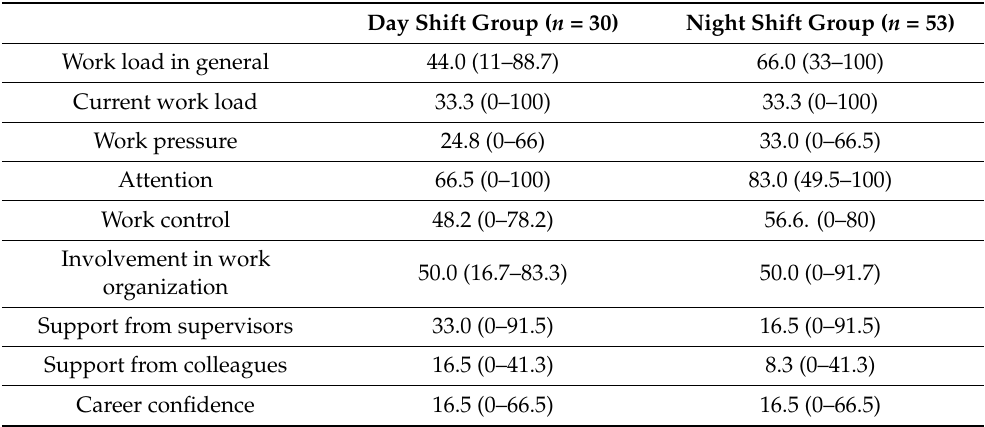
Table 2. Median (range) self-reported scores for occupational stress risk factors (from the French National Research and Safety Institute questionnaire) in the day shift and night shift groups. The scores were assessed on a 0-to-100 scale: the higher the score, the higher the level of the occupational psychosocial risk